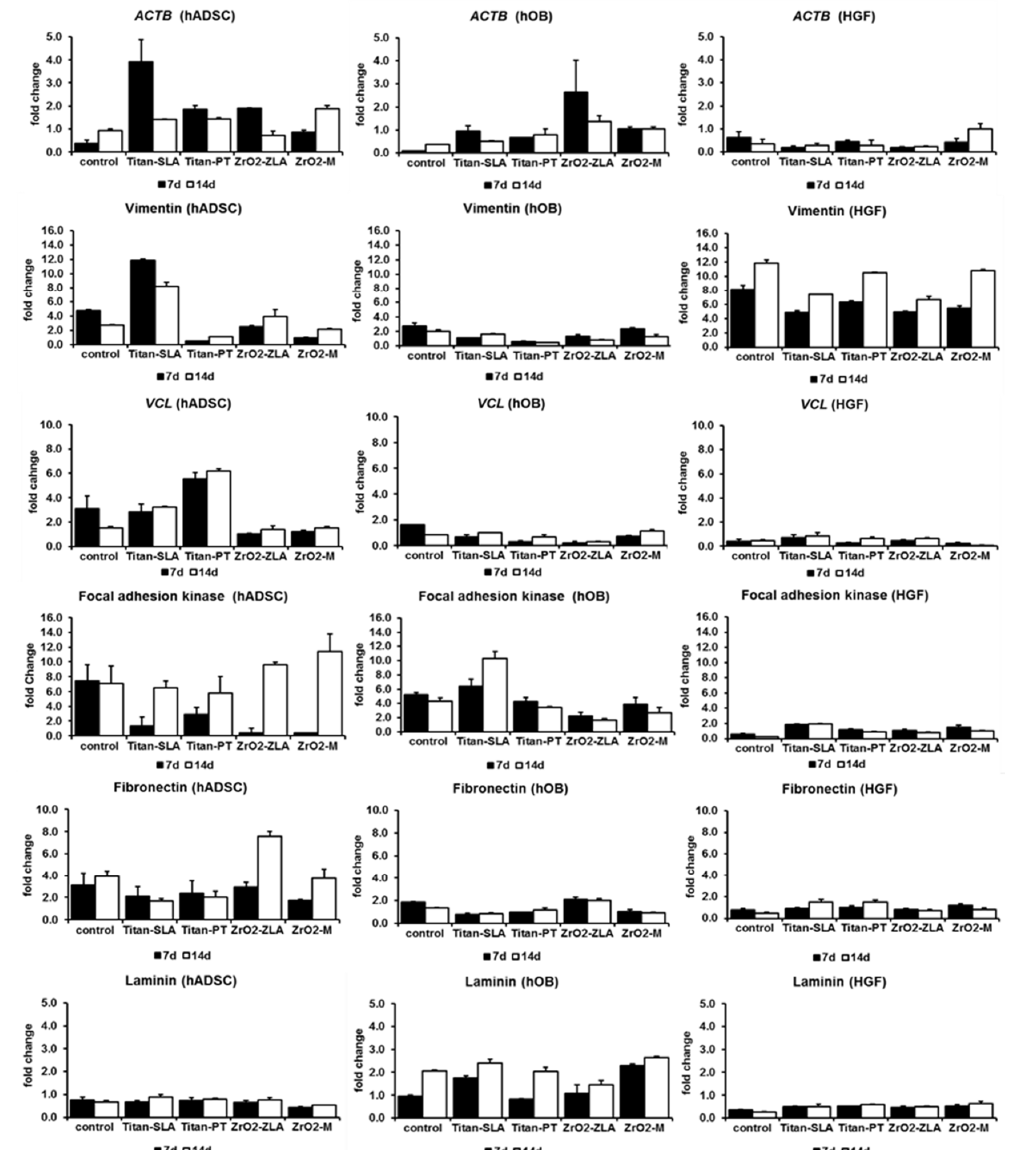
Figure 4. Fold changes of the focal adhesion and extra cellular matrix markers compared to day 1 (standard abbreviation as error).